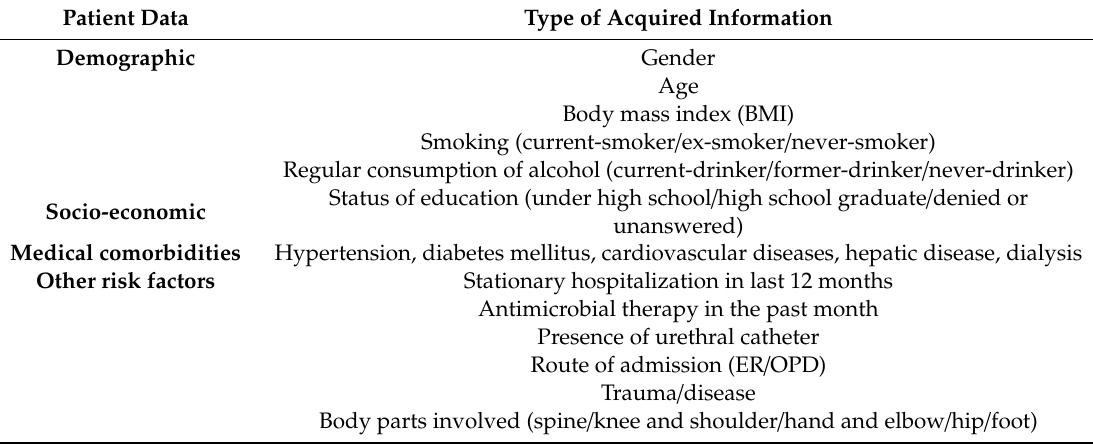
Table 1. Overview of collected patient